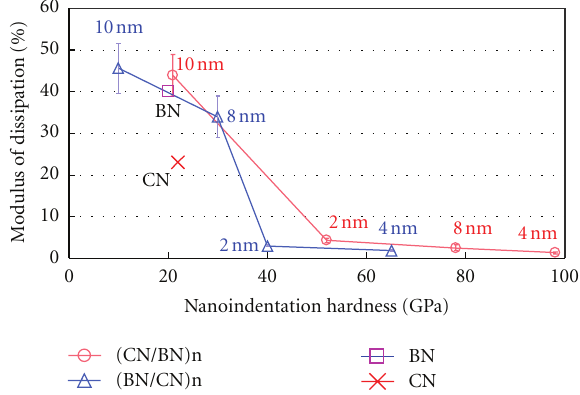
Figure 8: Relationship between nanoindentation hardness and modulus of dissipation of multilayer